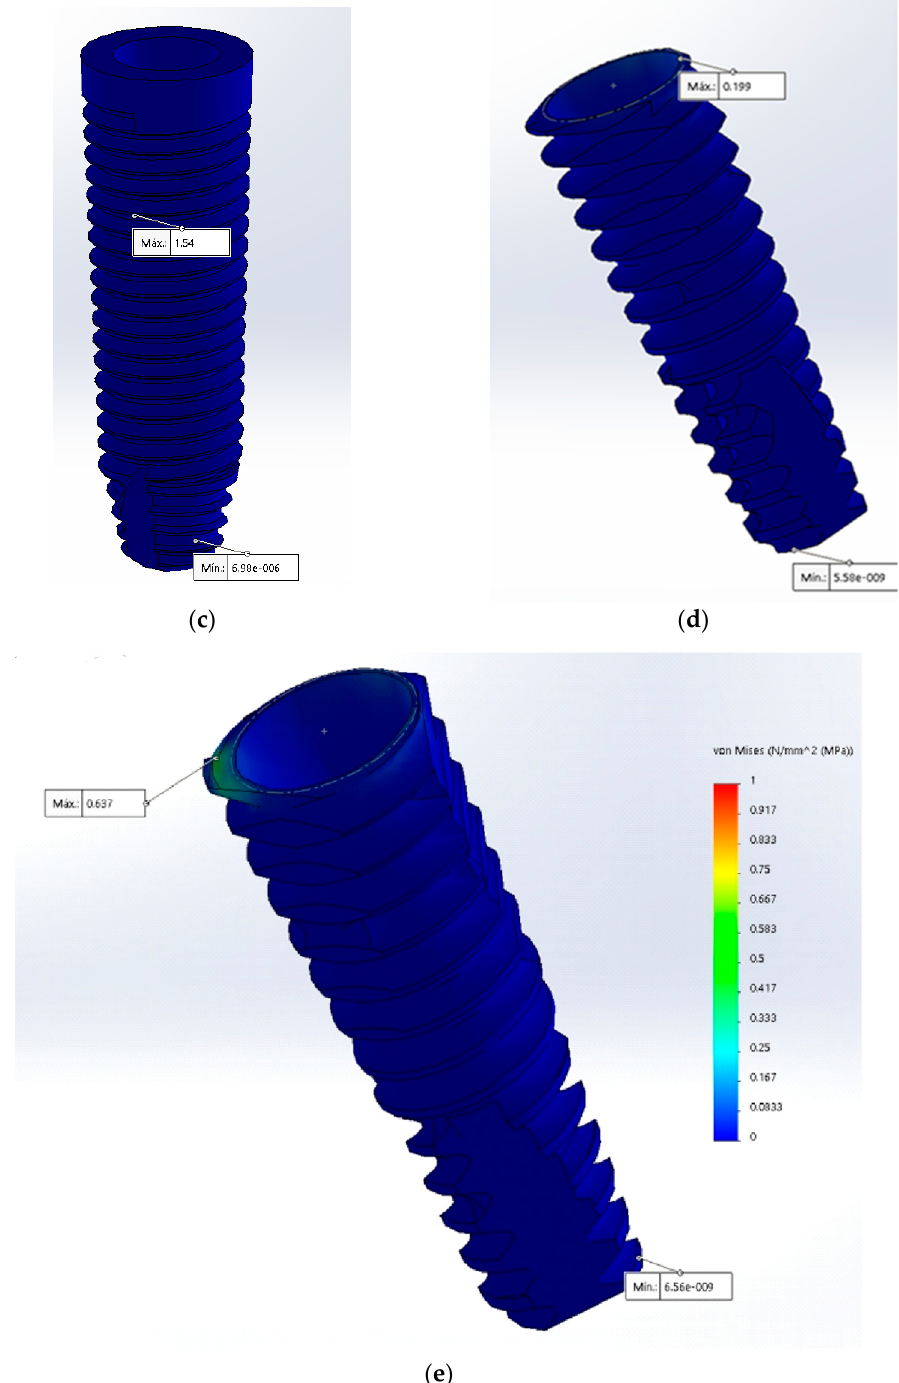
Figure A4. Maximun stress in the implant with 150 N: ( a ) External hexagon; ( b ) internal hexagon; ( c ) morse taper; ( d ) conical connection; ( e ) conical triangular connection.